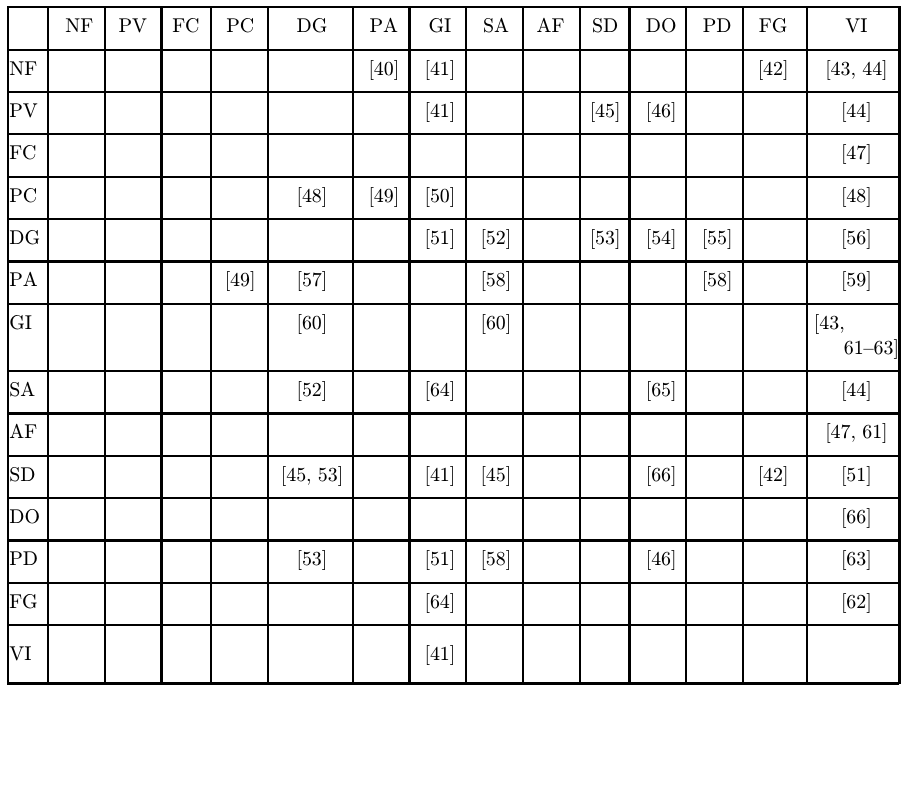
Table 2. Interdependencies between factors linked to youth violence. In this table, references are orga- nized into an asymmetric matrix, such that the references in the (cid:1) th row, (cid:2) th column are for factor (cid:1) leading to factor (cid:2) .